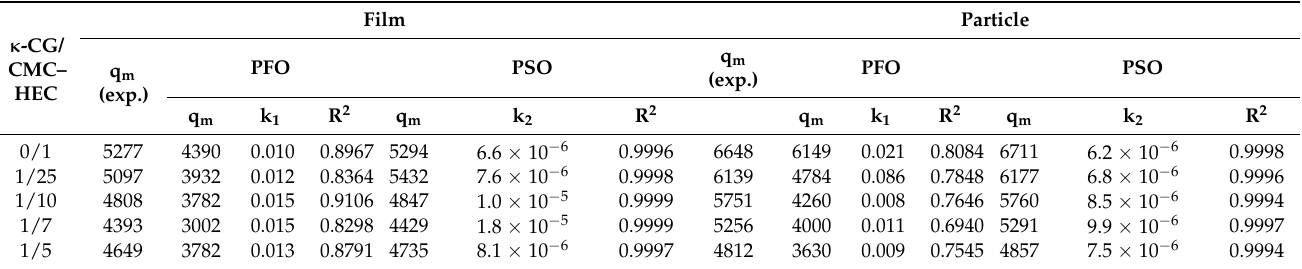
Table 2. Kinetic-model parameters obtained using the linearized PFO and PSO models for the water absorption onto the dried gels in deionized water (pH 7) at 25 ◦ C.